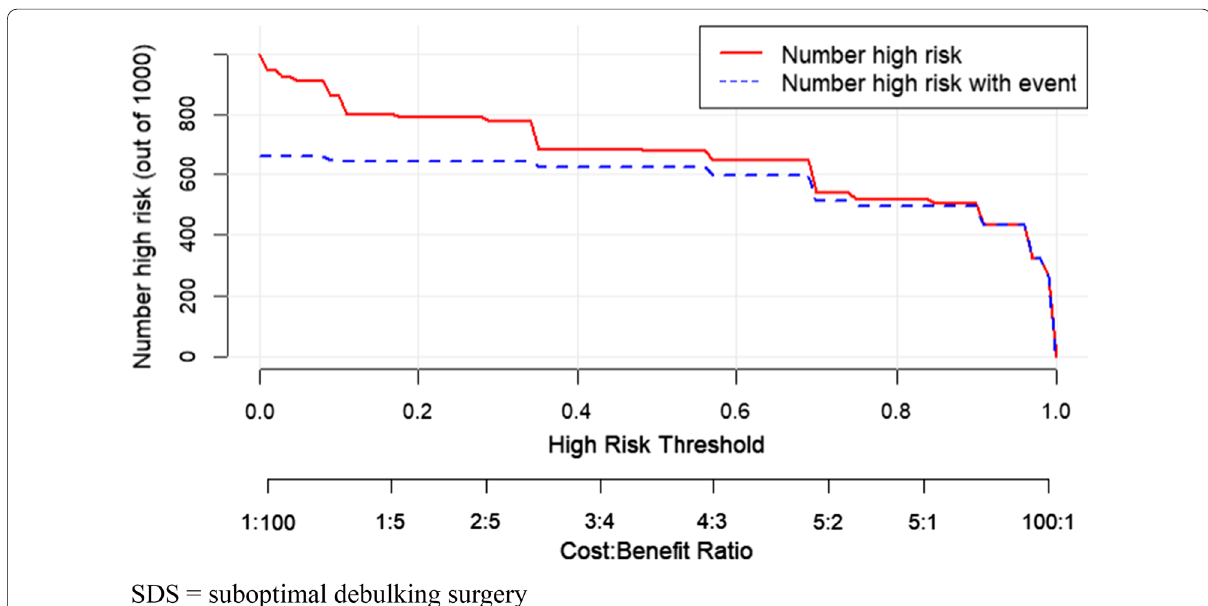
Fig. 7 Clinical impact curve in prediction of SDS. SDS suboptimal debulking